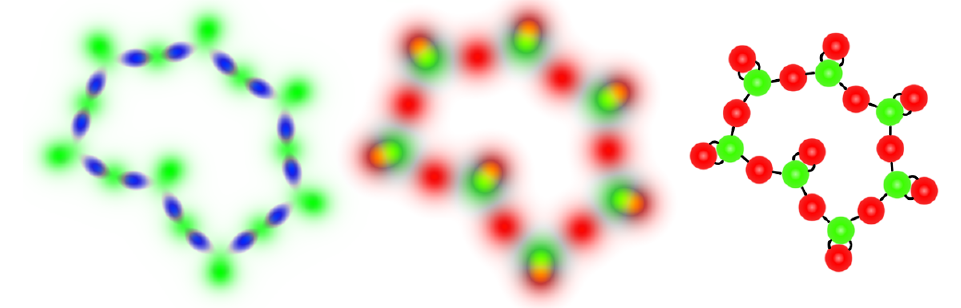
Figure 12 : ( Q 1 ; Q 2 ) = (4 ; 2) nonminimal vortex ring network. The (cid:12)gure contains 3 elements from left to right: an energy density plot, a (cid:12)eld density plot and a sketch of how the red and green vortices are interconnected. The (cid:12)rst two plots are made using the coloring scheme of (cid:12)gure